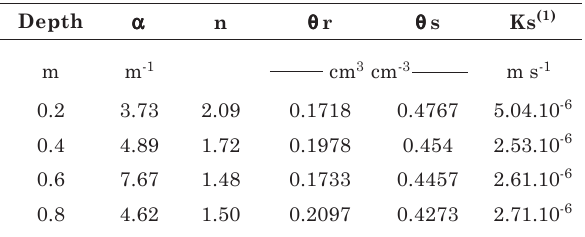
(1) Mean value by the method of constant head